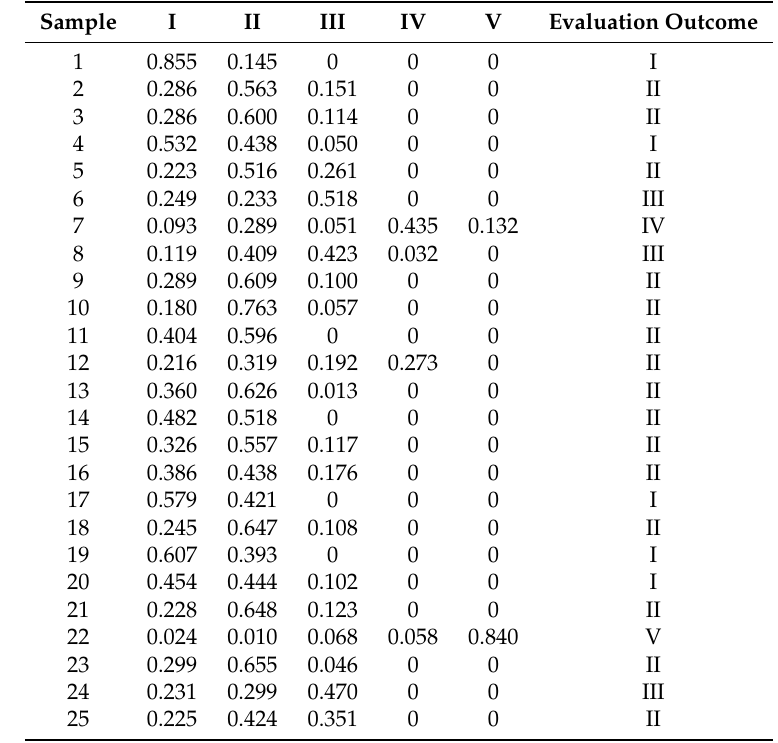
Table 5. Results of fuzzy comprehensive evaluation of the quality of the collected groundwater samples, based on the fuzzy value of each class (I ∼ V, Table 4); the class with the highest value indicates the final outcome of the